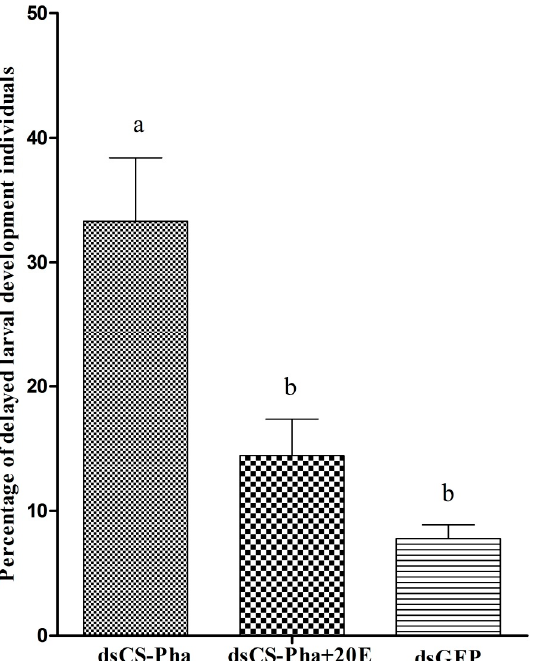
Figure 8. Delayed larval individuals subjected to ds Cs-Phm , ds Cs-Phm +20E, and dsGFP. The columns indicate average values, and vertical bars represent SE. Letters above the bars indicate statistical differences between treatments at p < 0.05.